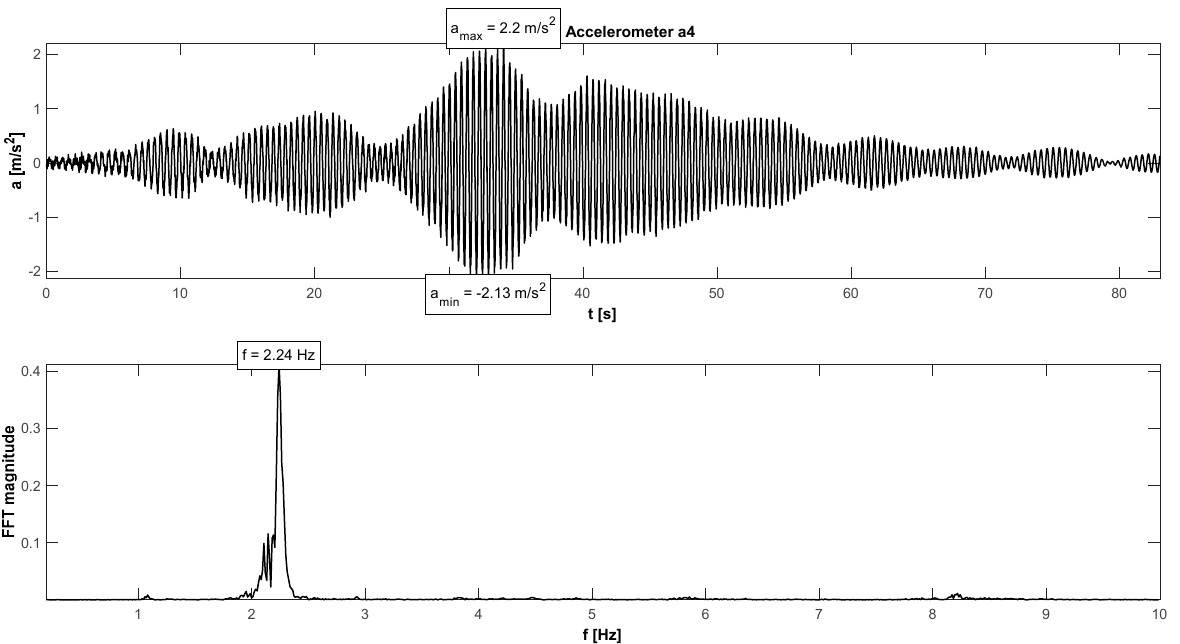
Figure 16. Signal of vertical vibrations in the time and frequency domain registered for 12 people running.